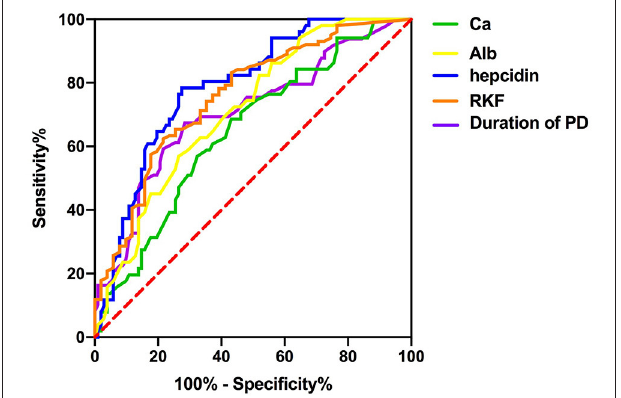
FIGURE 1 | ROC curves for serum hepcidin, Ca, Alb, duration of PD, and RKF.